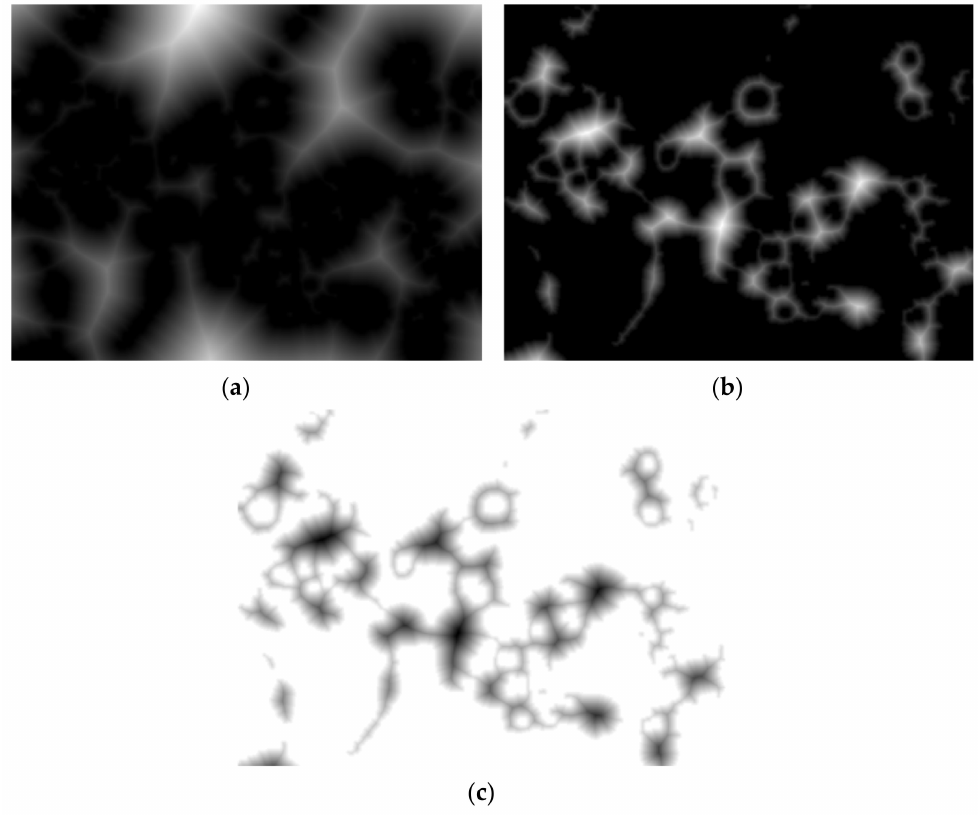
Figure 11. ( a ) Euclidean distance transform, ( b ) EDT on complement image, ( c ) negated ( b ). Since we have come to the point where each pool represents the cell region connected as a graph, all that is left to do is to finally apply the watershed transform but with the observation that typically over-segmentation (Figure 12a) may appear due to the fact that each and every local minimum is settled to be a catchment region; hence, some parts of cell are segmented inconsequentially. In this direction, a mask of potential nuclei (Figure 12b) is determined using the imextendedmin function that computes deep regional minima locations. The minima transform given as an input parameter is 3, and the default 8-pixel connection is